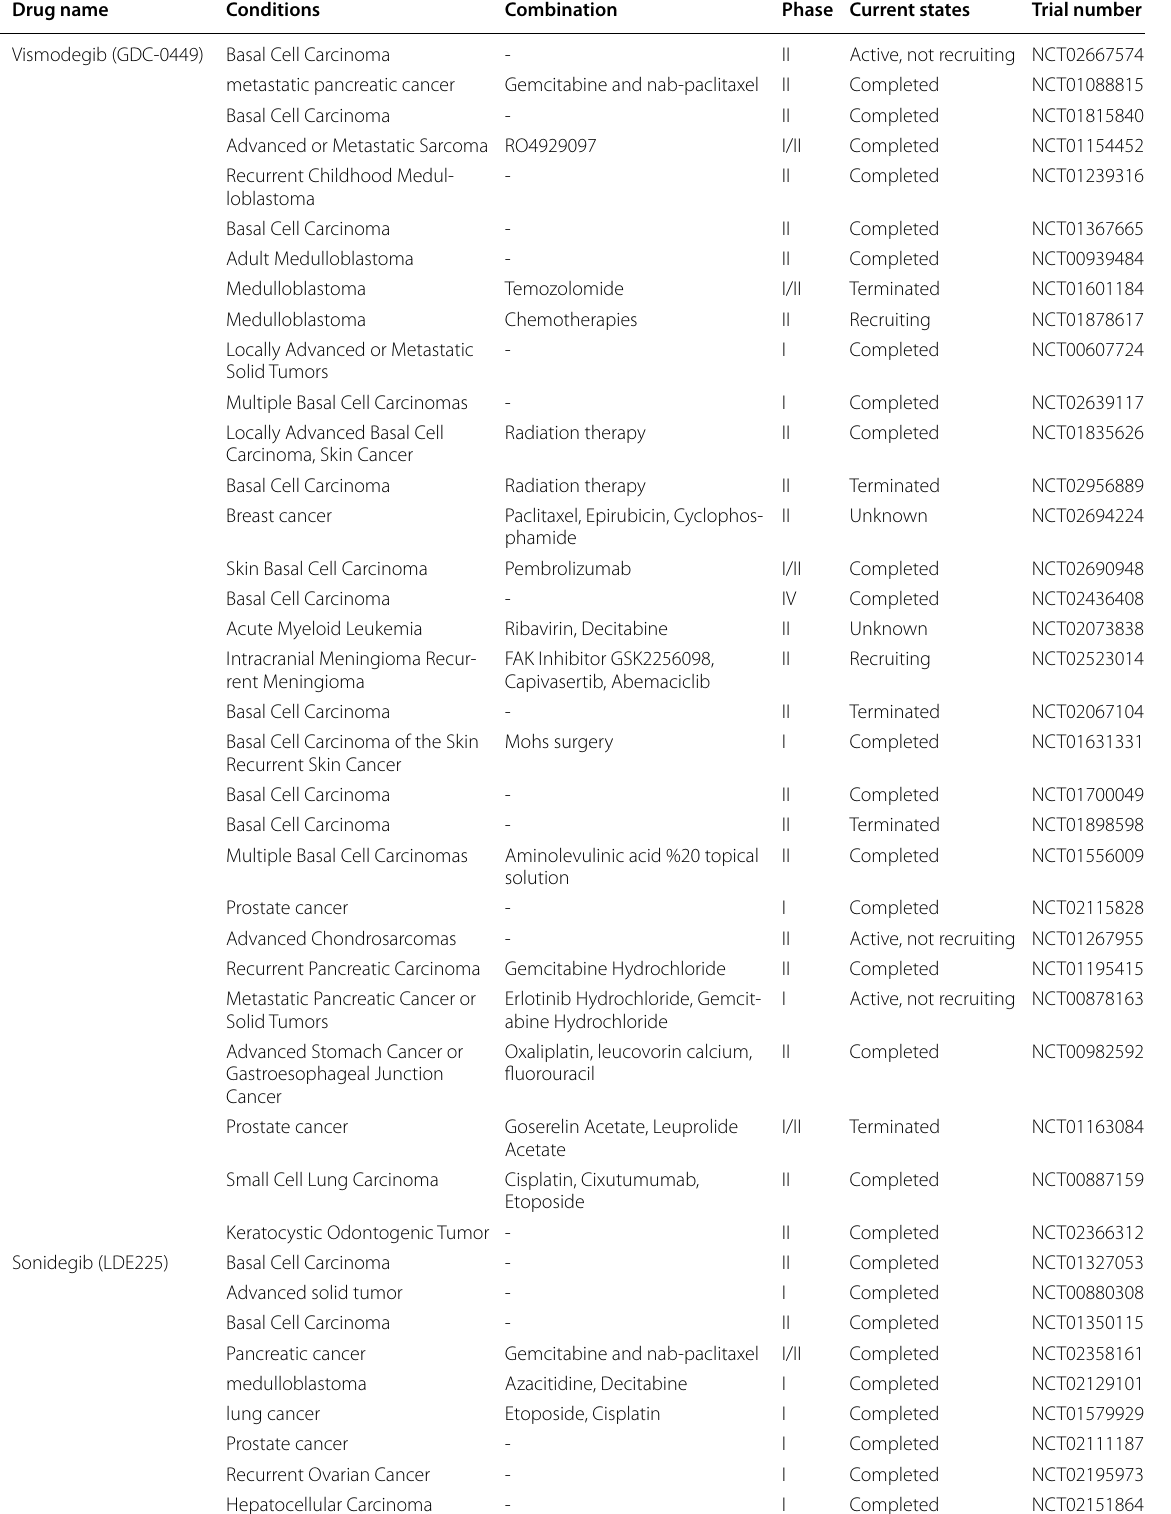
Table 2 Recent clinical trials targeting the Hedgehog pathway Target Drug